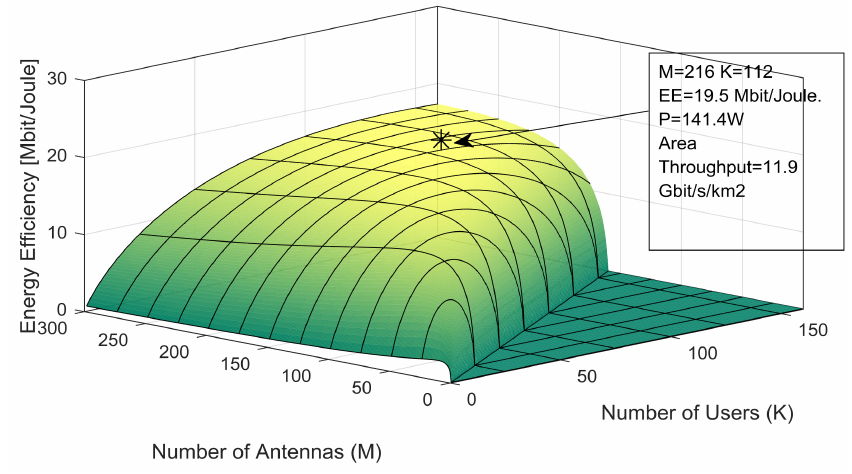
Figure 10. Energy efficiency (EE) at different area of coverages.